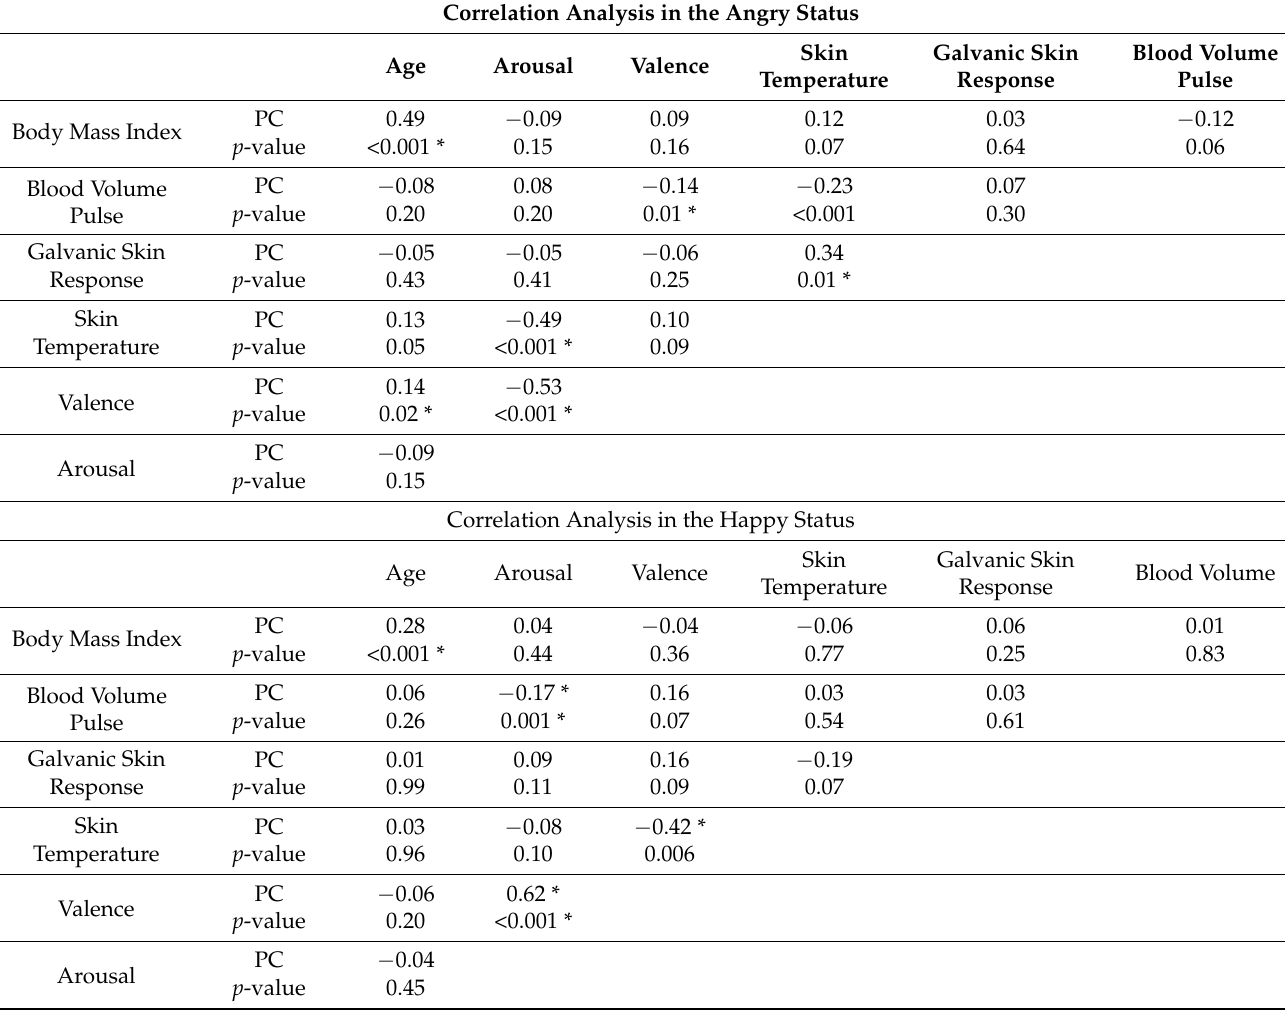
Table 3. Correlation analysis in different emotional